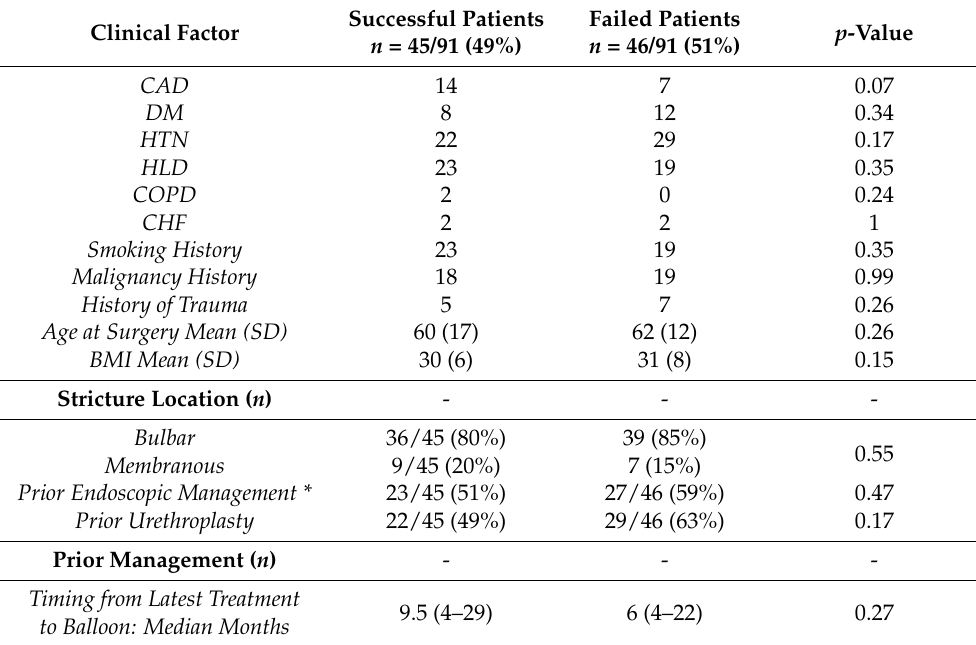
Table 1. Clinical/Stricture Characteristics of Success vs. Failure